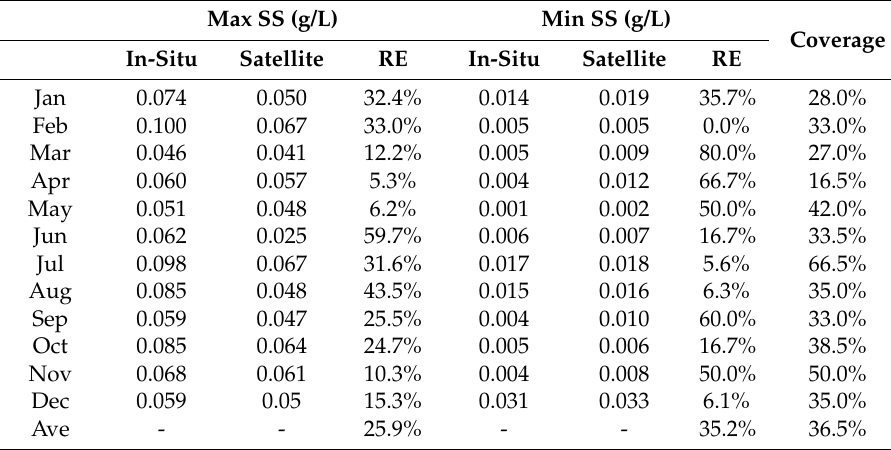
Table 5. Relative errors (RE, %) of maximum, and minimum suspended solids (SS) from valid MODIS observations compared with in situ measurements.